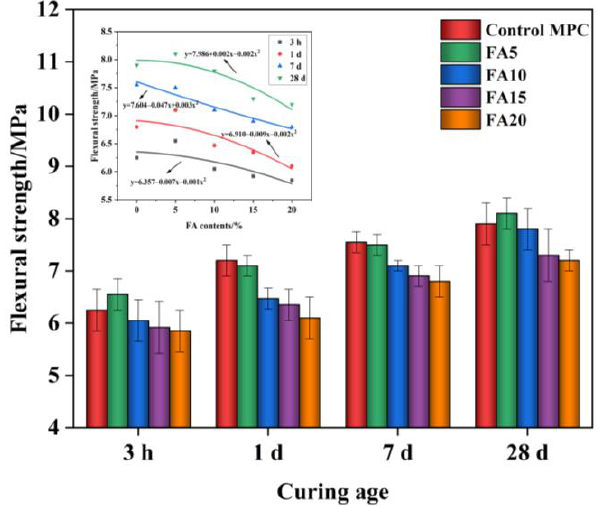
Figure 12. The effect of FA content on MPC flexural strength.